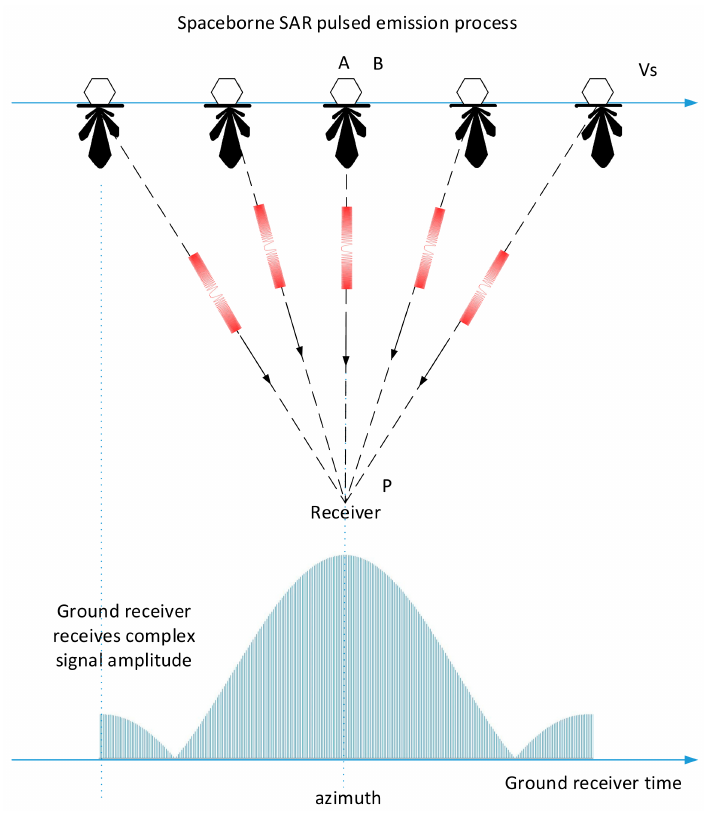
Figure 3. The situation where the squint angle of the antenna beam is